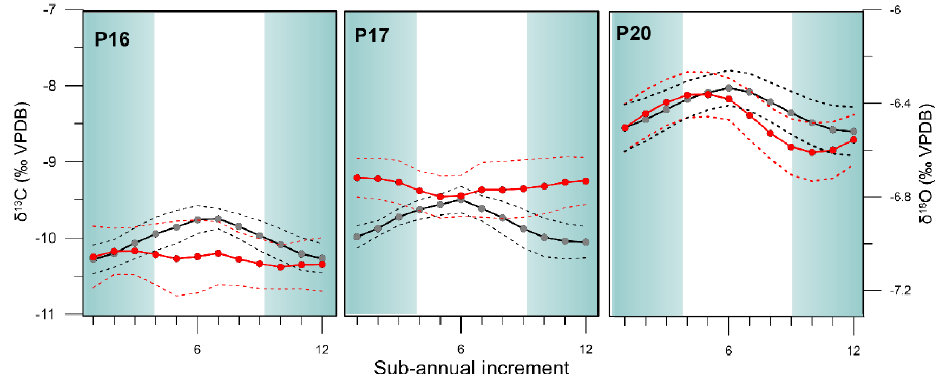
Figure 9. Annual stacks of δ 13 C (black) and δ 18 O (red). Dashed lines mark the 2 σ uncertainty. The x -axis intervals represent 1 year. Blue shaded areas indicate the winter season. For the years used; see Fig.